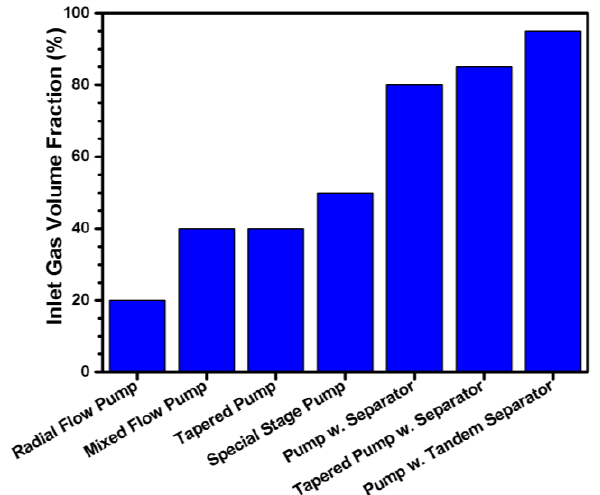
Figure 15. Comparison of different gas-handling techniques used in the ESP system [142].